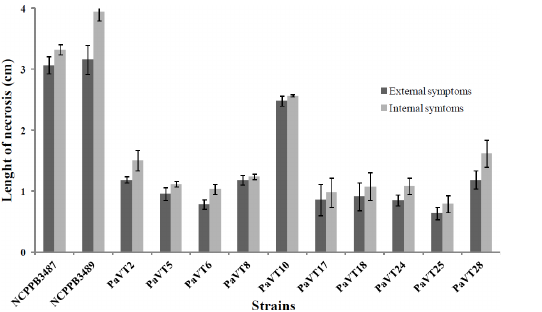
Fig 6. Length of external and internal necroses developed on hazelnut plants (cv. Tonda Gentile Romana) inoculated through leaf scar. The length was measured after 4 weeks post infection. The reference strains of Pseudomonas avellanae (NCPPB 3487 (= BPIC631) and NCPPB 3489) previously isolated in Greece from bacterial canker symptoms produced mild external and internal necroses, together with the strain PaVT10 isolated in this study. The rest of the strains tested in this study caused only weak necrosis on the inoculated plants. The error bars represent the standard error of the measurements.